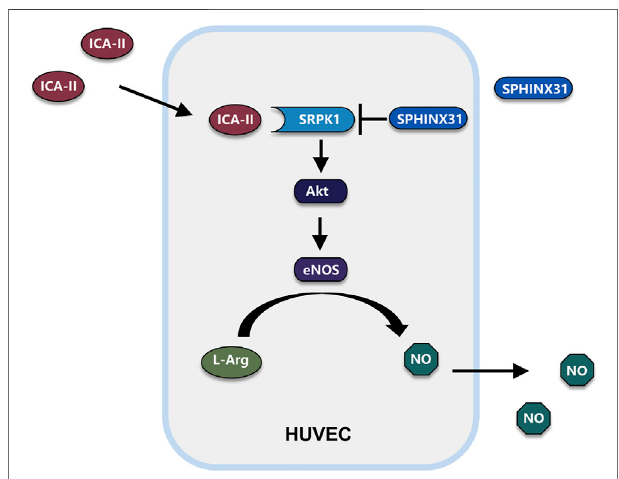
FIGURE 9 | Schematic illustration of potential signaling pathways affectedby ICA Ⅱ . Possible mechanism ofICA Ⅱ inthe PA-induced endothelial dysfunctionbyactivatingSRPK1-Akt-eNOSsignalingpathwayandpromoting the production of NO.